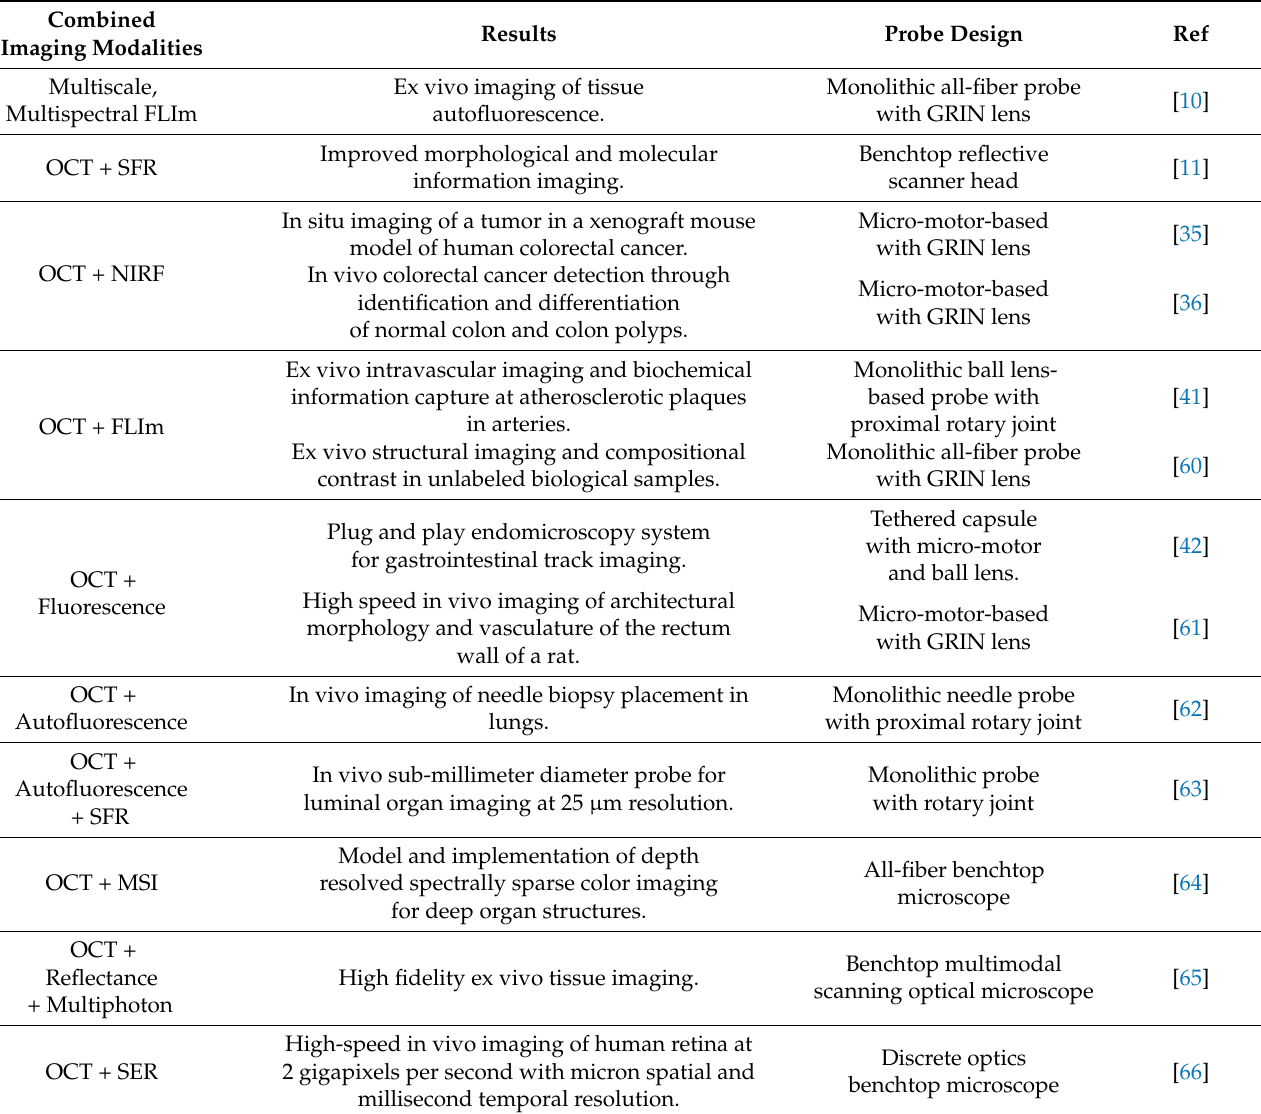
Table 1. Summary of published applications for more than one DCF-based co-registered imaging modalities post